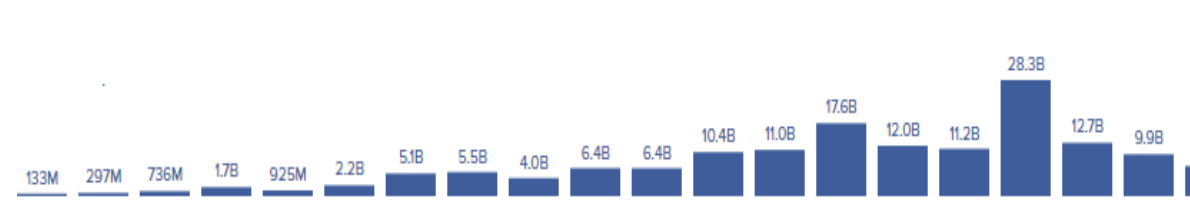
Figure 3: China's volume Loan given to Africa from 2000 to